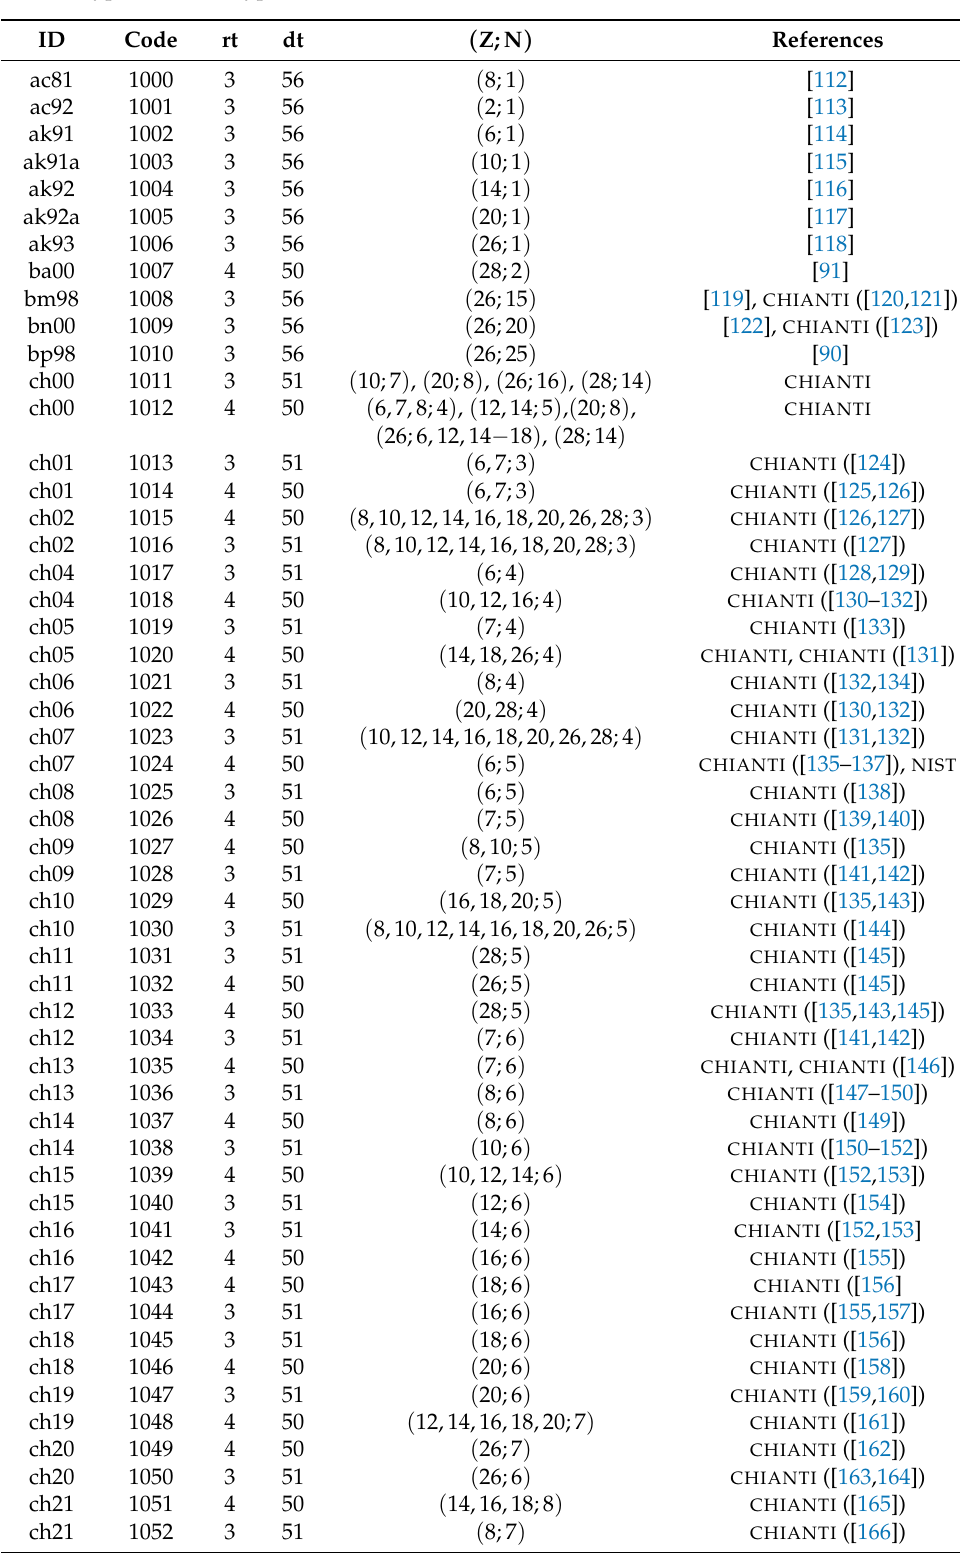
Table A2. Data provenance including the CHIANTI [61], PP95 [63], and AMDPP [64,65] compilations. rt = rate type. dt = data